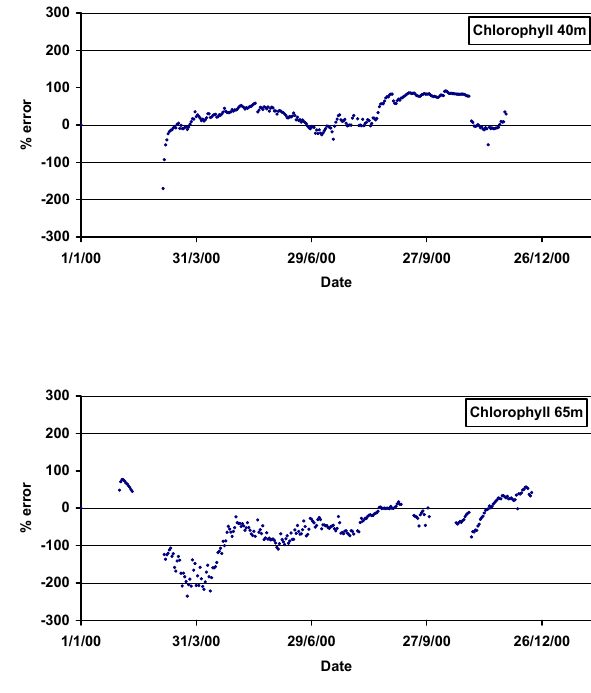
Fig. 10. The percentage error (100*(Data-Model)/Data) for chlorophyll-a at (a) 40m and (b) 60m.